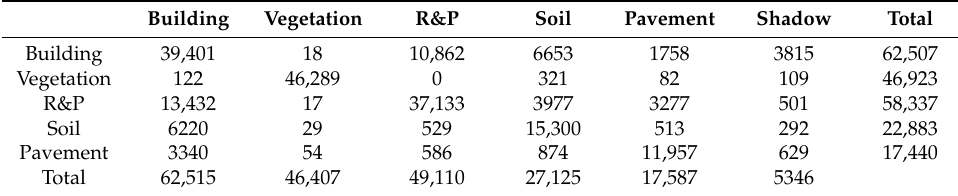
Table 3. Confusion matrix of the high-resolution image classification map, where the reference is shown as Figure 15. The values in the table indicate the numbers of pixels.